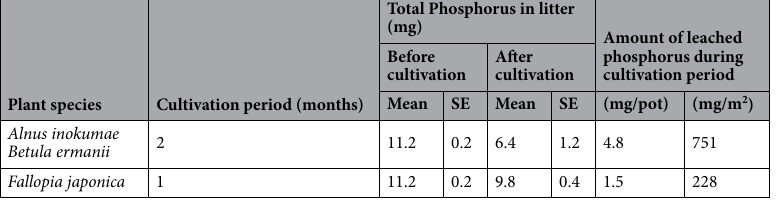
Table 2. Amount of leached phosphorus during the cultivation period ( n = 4).